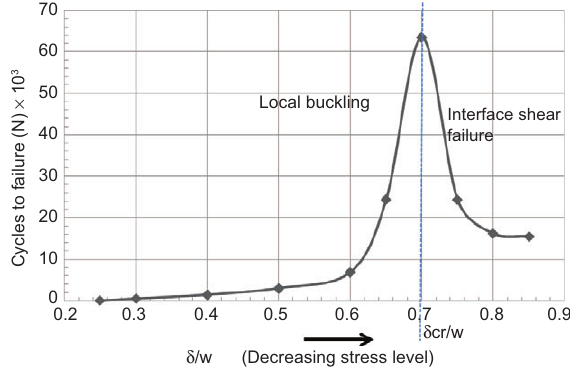
Figure 7 Average number of cycles to failure as a function of flaw size for Type 2 specimens. Shift in mode and site of failure at the transition point δ / w cr